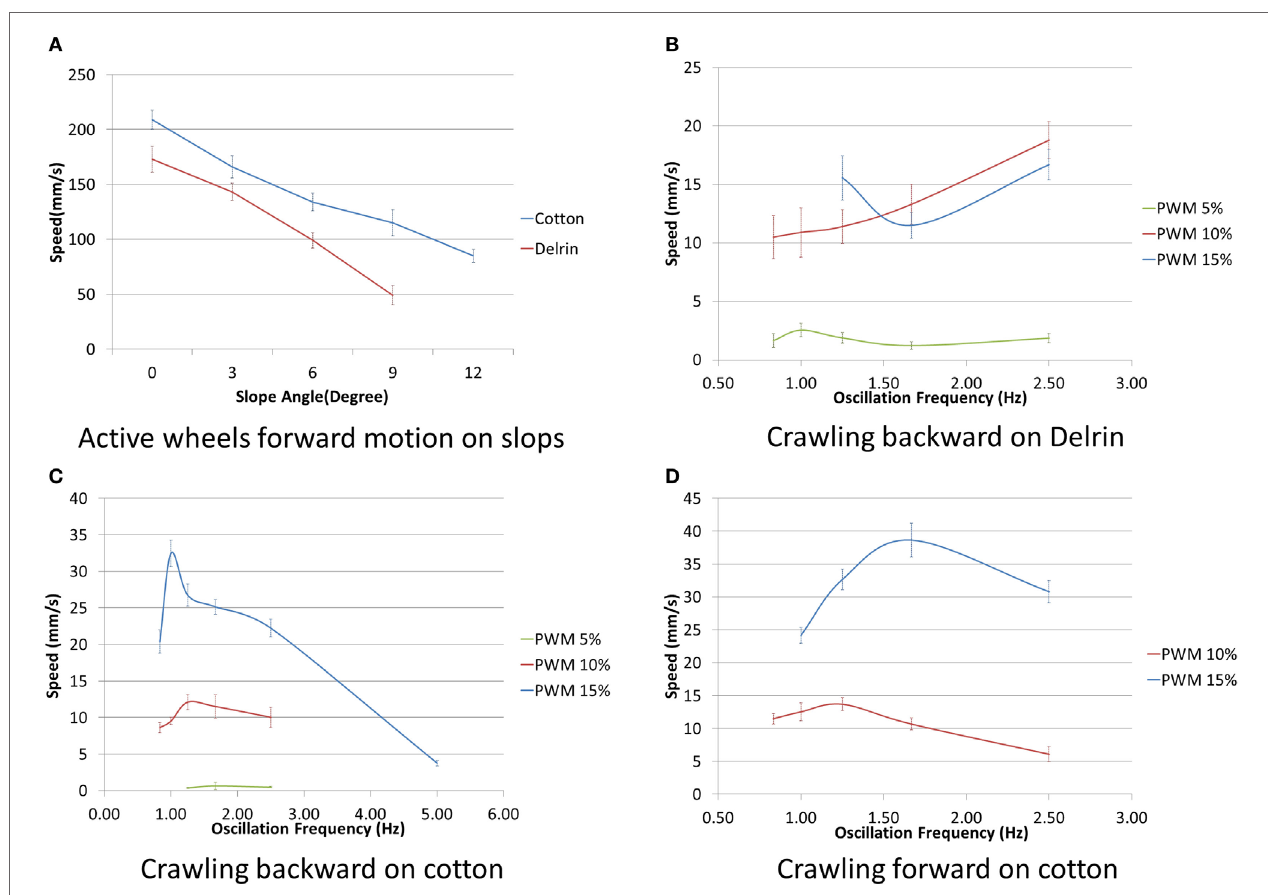
FigUre 7 | (a) Velocity of the robot in forward locomotion on cotton and Delrin with different angles. (B–D) The resulted speed of crawling on cotton and Delrin with different oscillation frequencies and power